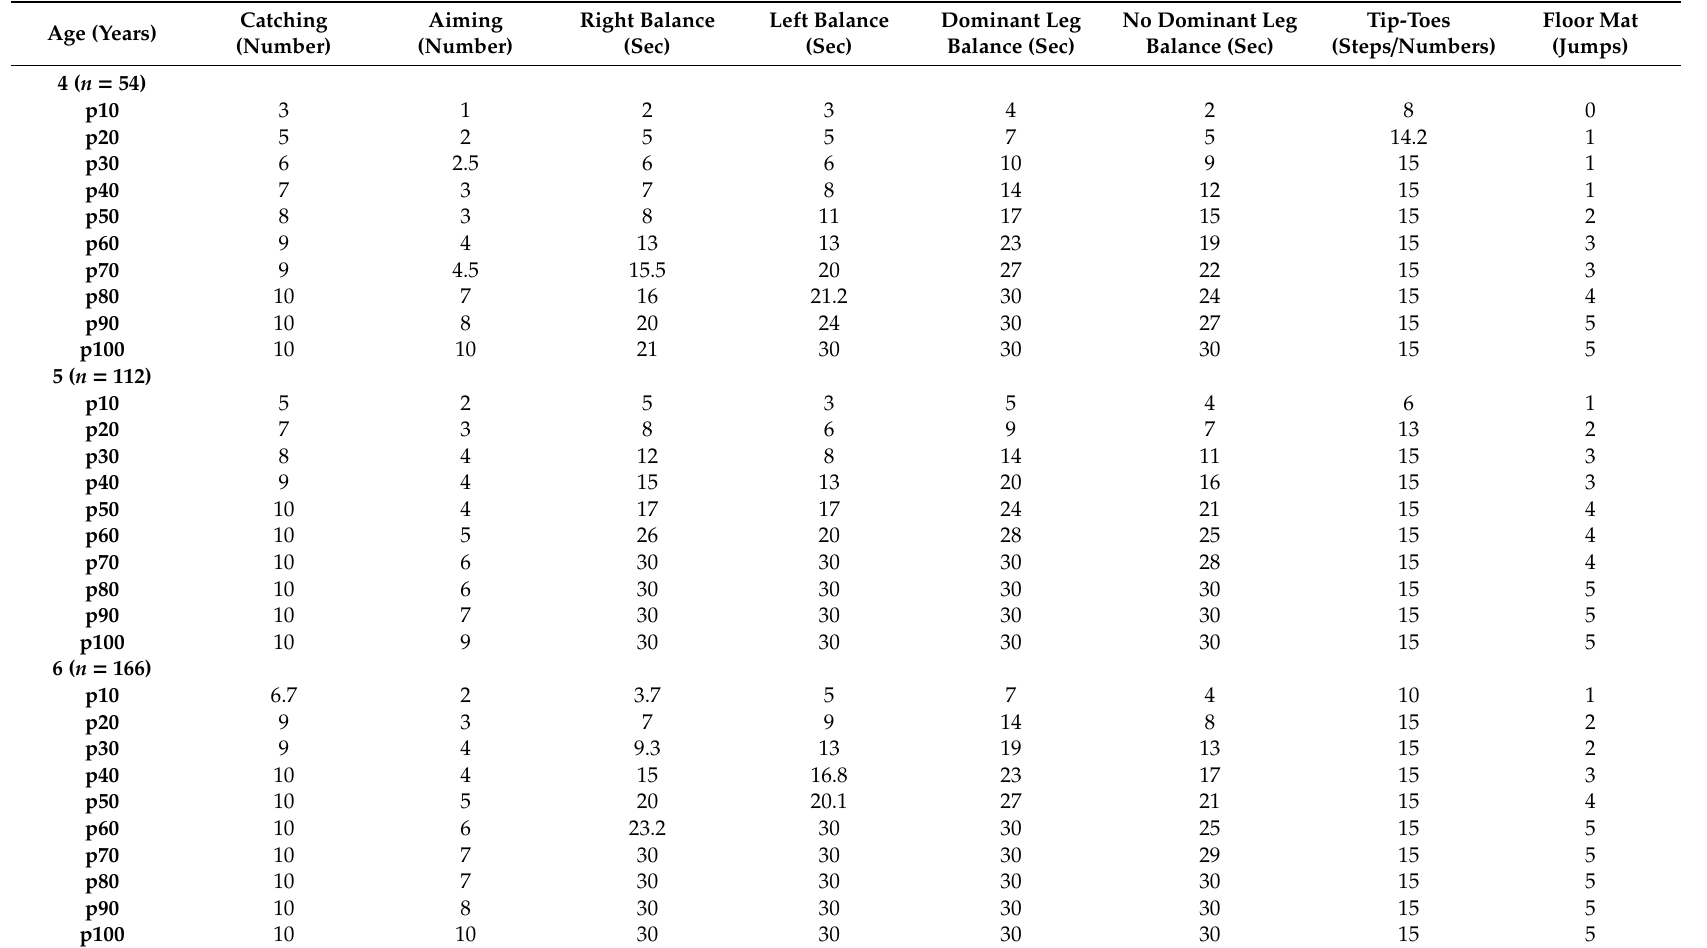
Table 8. Percentile values for boys in gross motor